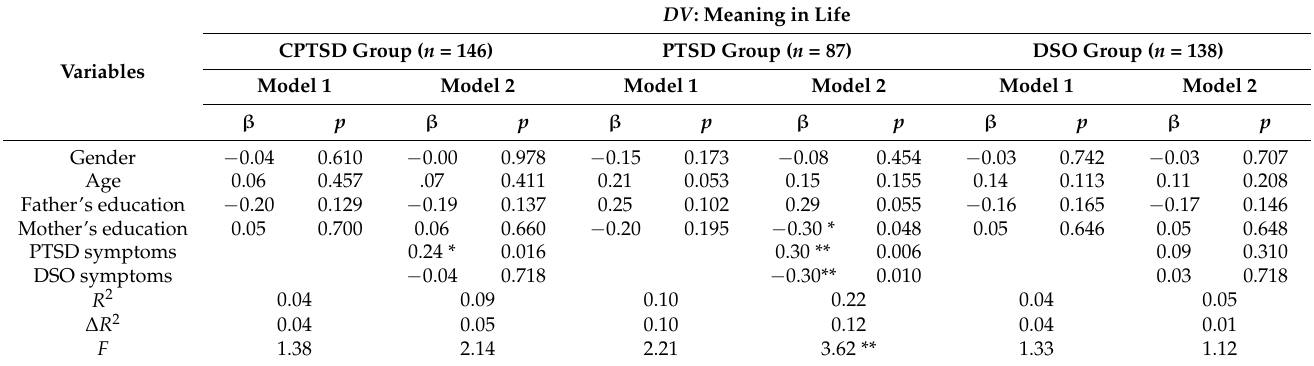
Table 5. Hierarchical linear regression analysis results for PTSD symptoms and DSO symptoms predicting eudaimonic